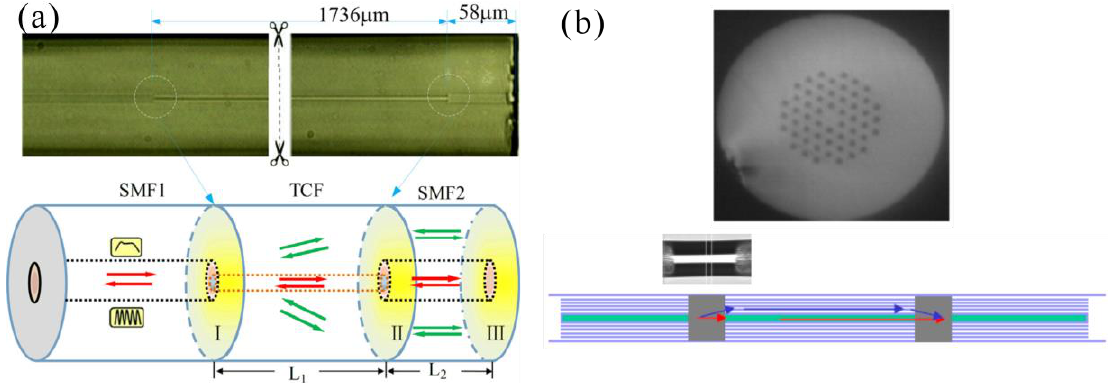
Figure 18. ( a ) Microscope image and schematic diagram of the SMF-thin core fiber (TCF)-SMF structure [266]; ( b ) Schematic of the SMF-PCF-SMF structure and the cross sectional view of